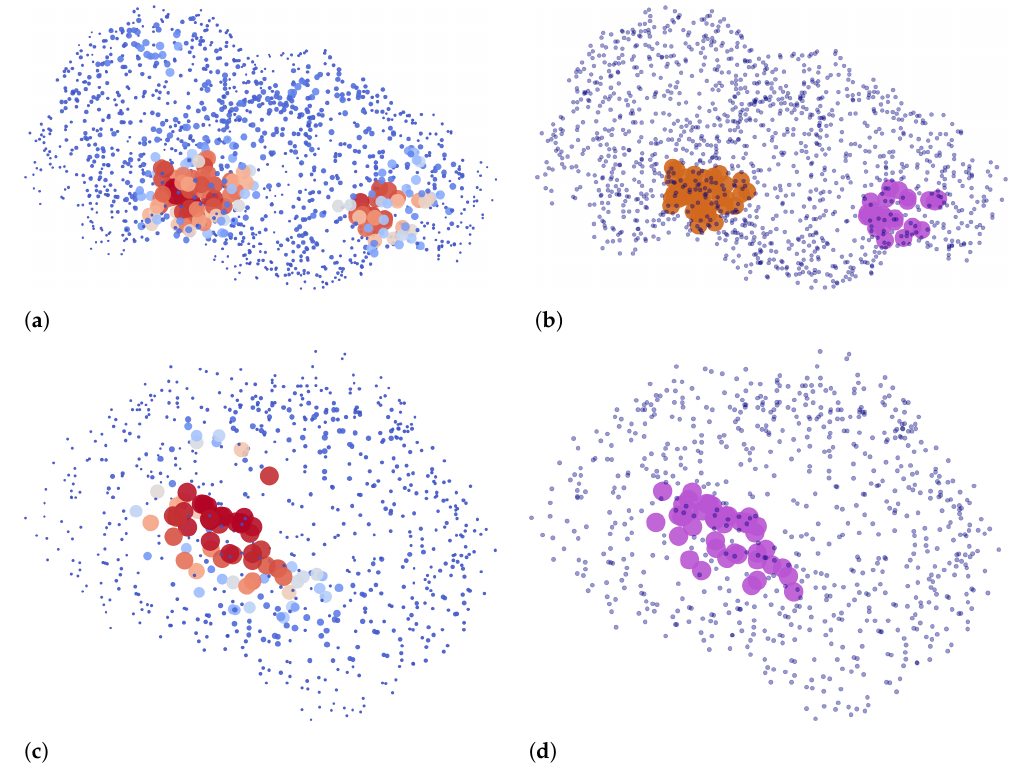
Figure 7. The input and the output of Algorithm 1: Two left figures show points on the protein surface with respect to their predicted ligandability, where higher values are denoted by larger and darker red points. Two corresponding right figures show the same two proteins, denoting the predicted binding sites that are returned by the algorithm based on ligandability predictions. Points that are a part of a binding site are drawn with larger circles. Different binding sites for each chain are colored differently with either purple or brown. Other points are denoted with blue dots. ( a ) Predictions for 3nk7, chain B [39,40]. ( b ) Predicted binding sites for 3nk7, chain B. ( c ) Predictions for 4rrg, chain C [41,42]. ( d ) Predicted binding site for 4rrg, chain